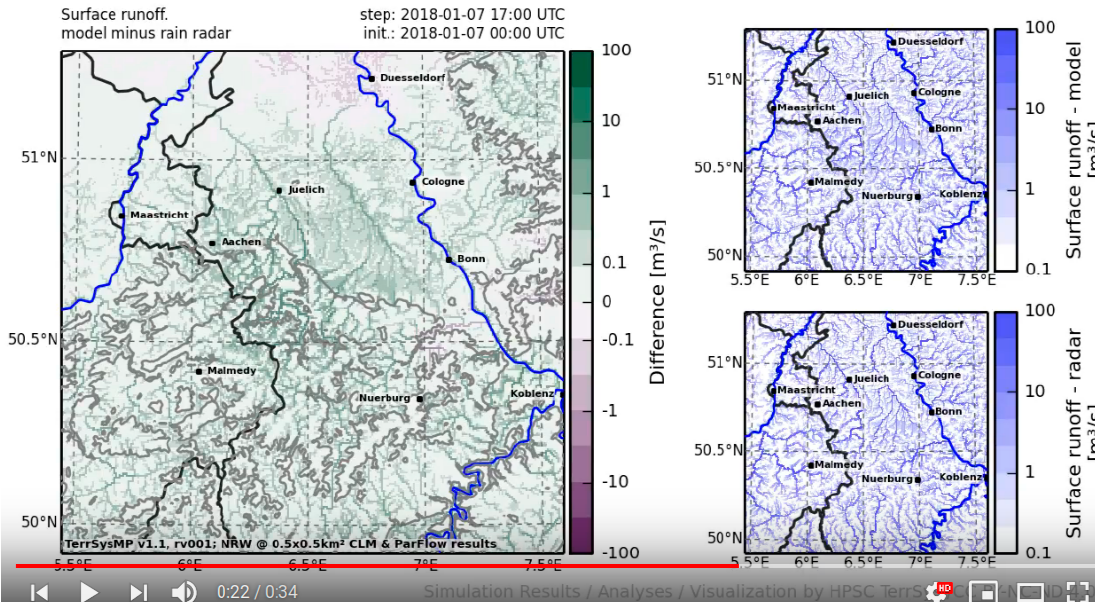
Figure 12. Difference plot for surface runoff (m 3 ·s − 1 ) between uncorrected and precipitation radar corrected simulations. The panels on the right show the runoff from the uncorrected (top) and precipitation radar corrected simulations (bottom).